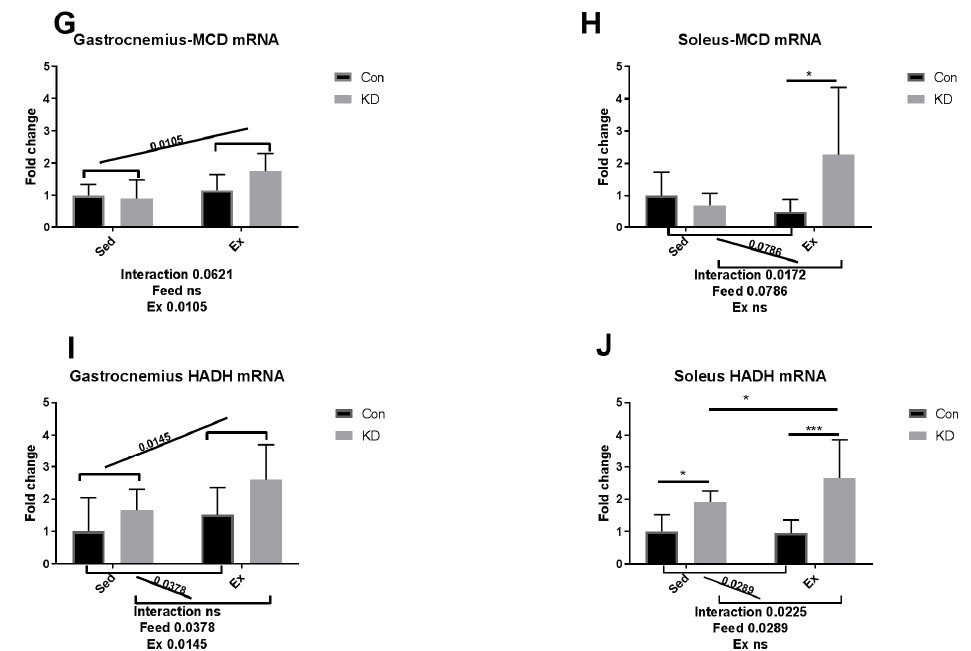
Figure 7. mRNA expression of fatty acid oxidation-related enzymes immediately after exhaustion in gastrocnemius ( A , C , E , G , I ) and soleus ( B , D , F , H , J ). ACO: acyl-CoA oxidase. CPT-1 alpha: carnitine palmitoyl transferase–1 alpha. MCAD: medium chain acyl-CoA dehydrogenase. MCD: malonyl-CoA decarboxylase. HADH: hydroxyacyl-coenzyme A dehydrogenase. ns: no significance observed. * p < 0.05 and *** p < 0.001. Significance between groups are marked using slashes.